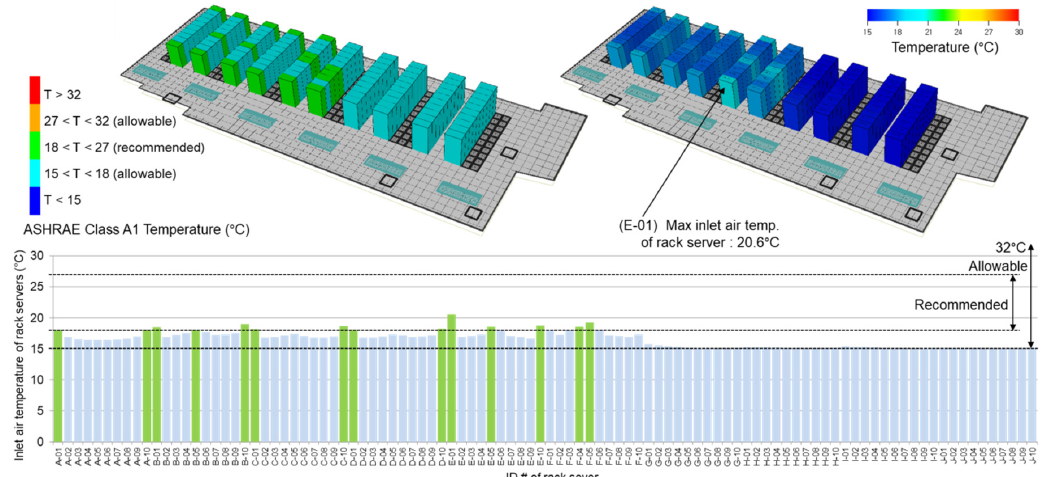
Figure 9. ALT-1 HAC with raised floor — the mean inlet air temperature of 100 server racks in normal cooling condition.